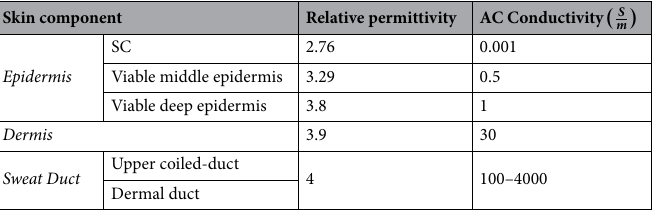
Table 1. Dielectric properties applied to the human skin model. The values of permittivity were taken from Ref. 6 . The ac conductivity range of the sweat duct was taken from Ref. 14 .